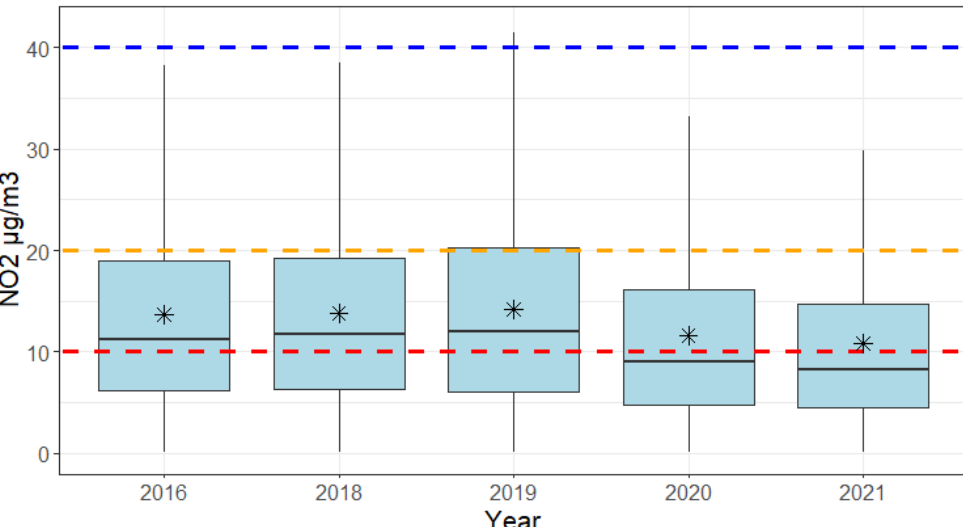
Figure 4. Boxplot of the measured annual median (black line), interquartile ranges and mean (stars) concentration of NO 2 2016, 2018–2021 at various ports of Helsinki. The blue line is the Finnish/EU limit of 40 µg/m 3 , which was in force during the studied years. The red line is the WHO 2021 recommended limit of 10 µg/m 3 and the orange line the EU proposal of 20 µg/m 3 .